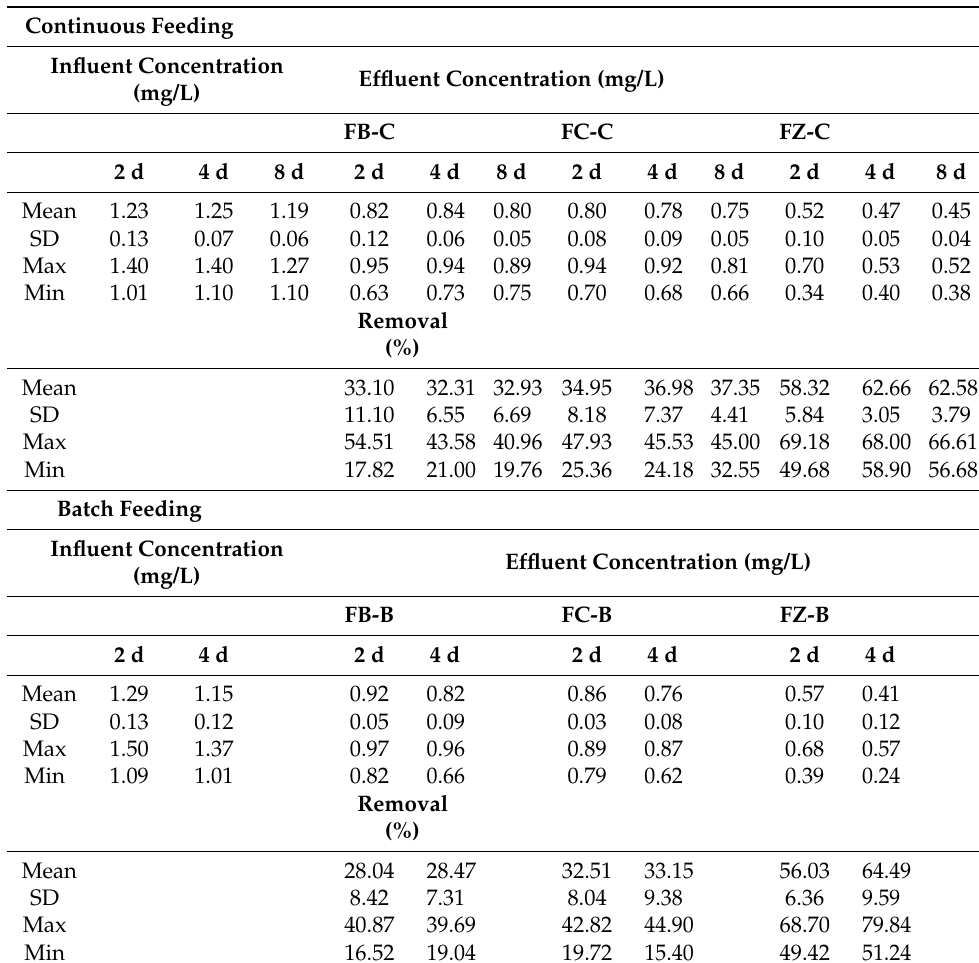
Table 3. Statistical data of influent and effluent of pyraclostrobin in filter